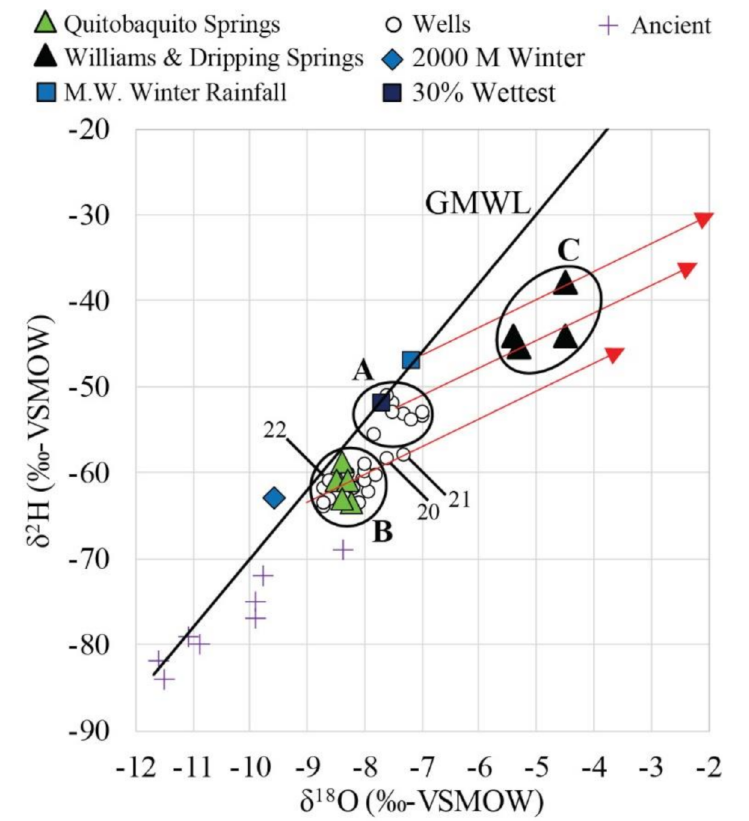
Figure 10. δ 18 O and δ 2 H values for mean rainfall (winter, and other values shown in Figure 7B), springs, and wells. Red arrows show the expected evaporation trend in the area with a slope of 3.16 obtained from Figure 8. Quitobaquito samples (from spring and pond) are shown by green-filled triangles in Group B. Ancient water samples (uncorrected pMC < 10) in southern Arizona from [2]. Wells east (upstream) of Quitobaquito along the Sonoyta River floodplain (7, 8, 10, 17, 18, 19) have ( δ 18 O, δ 2 H) ranges between − 8.7 and − 8.0% (cid:24) and − 64.1 and − 60% (cid:24)